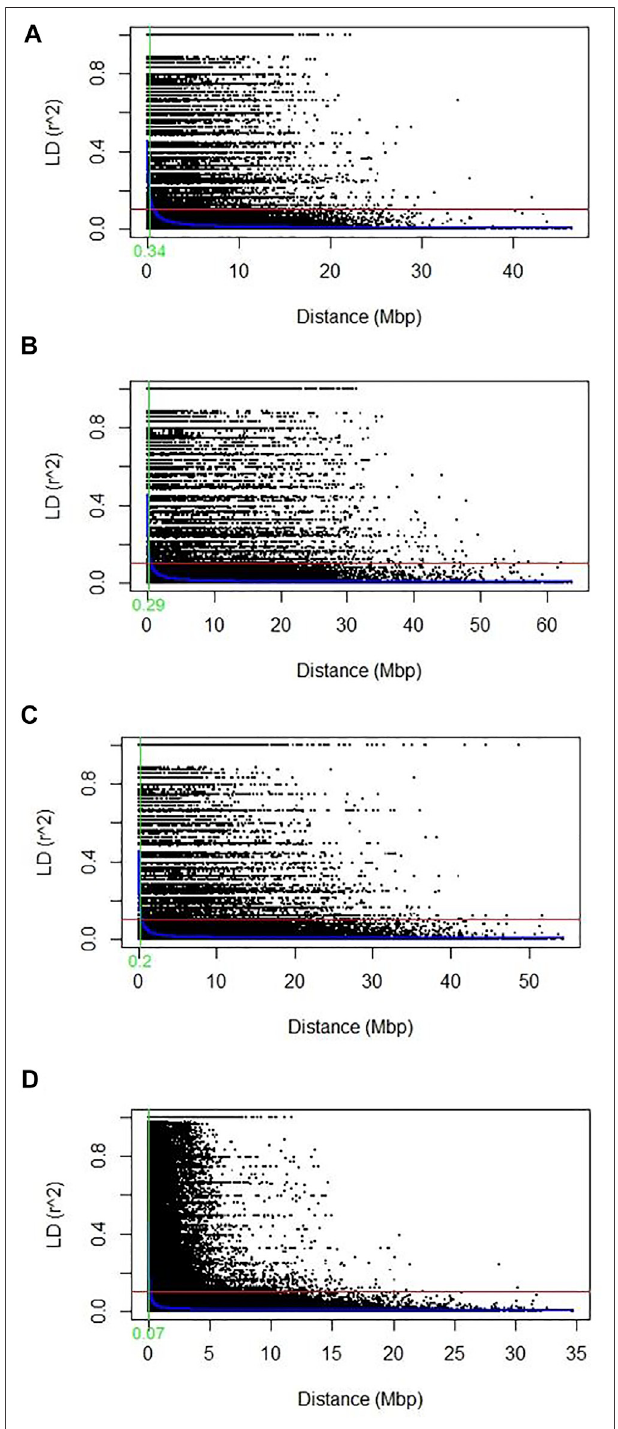
FIGURE 5 | Scatter plot showing the linkage disequilibrium (LD) decay across the genomes for 184 diverse Pakistani bread wheat accessions. The genetic distance in megabase pair (Mbp) plotted against the LD estimate ( r 2 ) forpairsofSNPs.ThesolidredlineshowedthethresholdLDvalueat r 2 = 0.1 and the solid green line showed the average LD decay point at which the LD curve intercepts the critical r 2 . The LOESS LD decay curve was presented